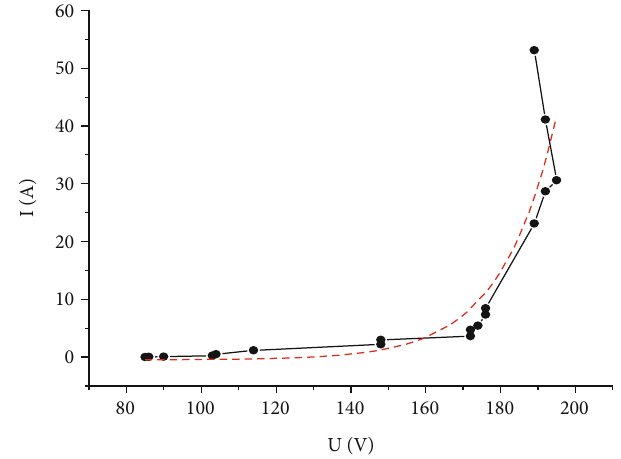
Figure 10: Volt ampere characteristics of TVS under wide